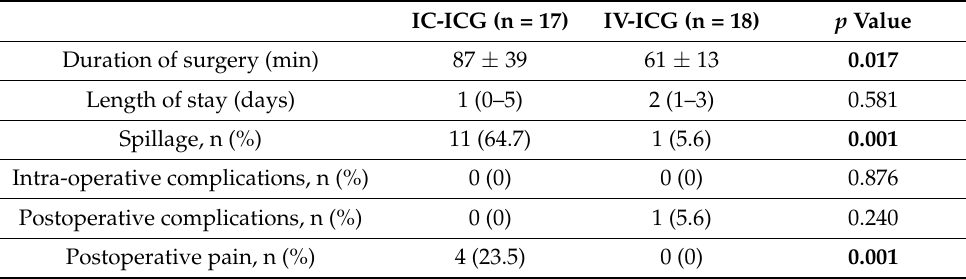
Table 4. Perioperative